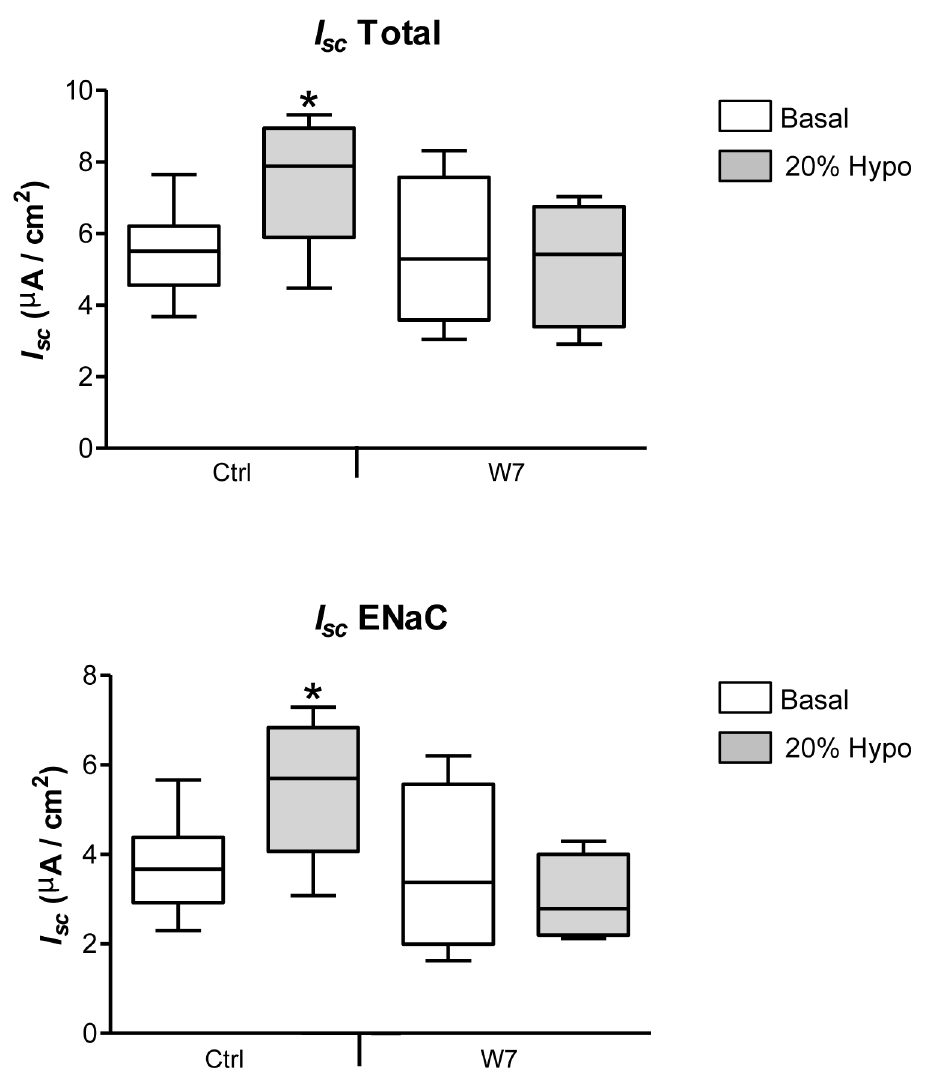
Figure 9. Inhibition of calmodulin kinase by W7 decreases the hypotonic shock current rise. Alveolar epithelial cells were pretreated for 20 min with 25 µM W7, a Ca 2+ /calmodulin antagonist, before I recording in Ussing chamber. Total ( I Total) and sc sc ENaC currents were evaluated in basal condition (Basal; white) or after 20% hypotonic shock (20% Hypo; gray). W7 pretreatment inhibited the total and ENaC I rise after 20% hypotonic shock. N≥4, *p<0.05 by Mann-Whitney Test compared to sc